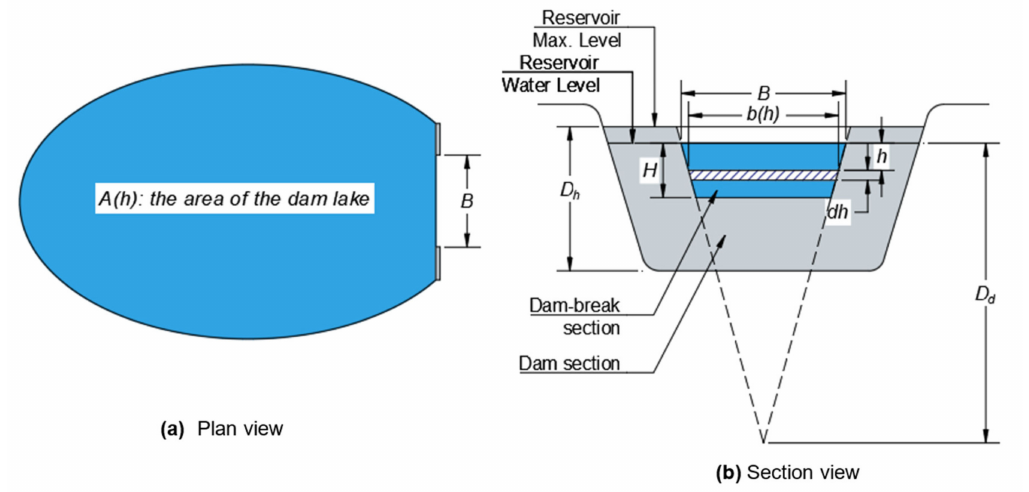
Figure 1. Dam-break plan ( a ) and section view ( b